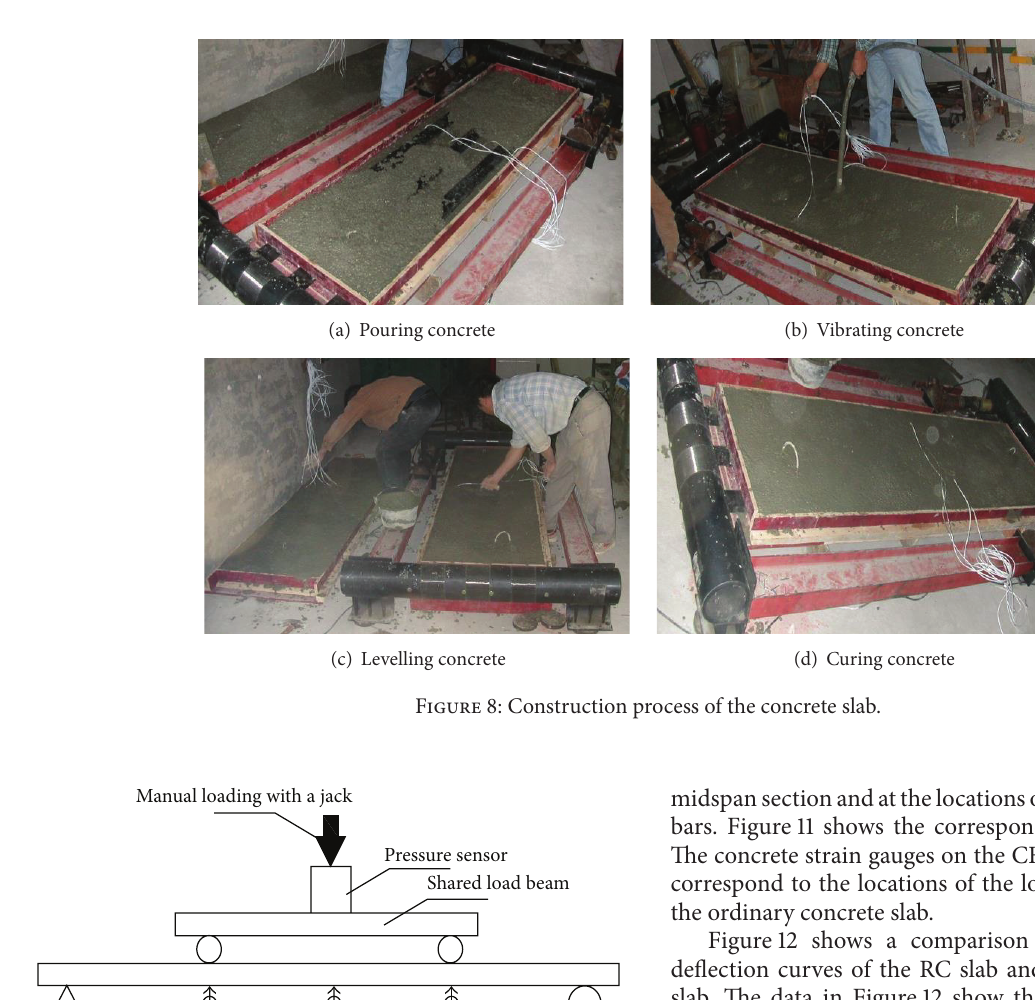
Figure 7: Construction layout of the CFRP sheet prestressed concrete slab (unit: mm).